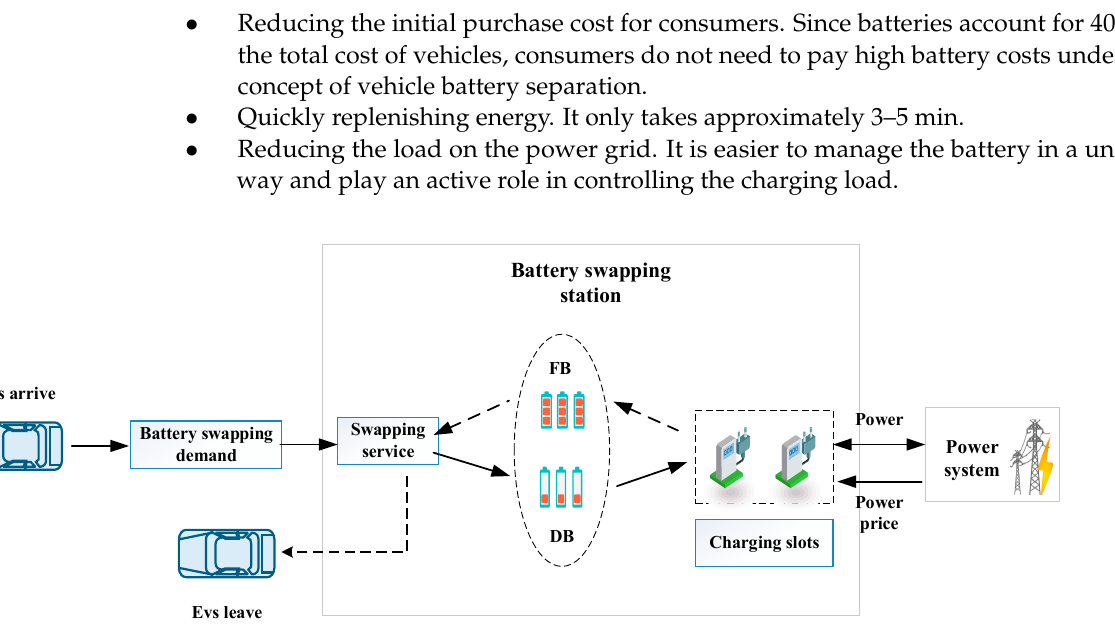
Figure 2. The operating framework of BSS.